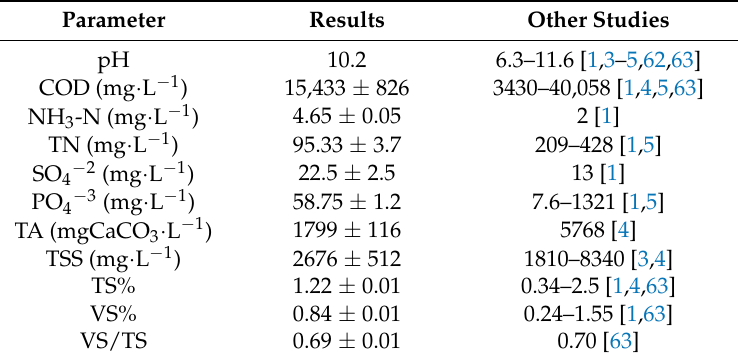
Table 2. Nejayote characterization compared with other